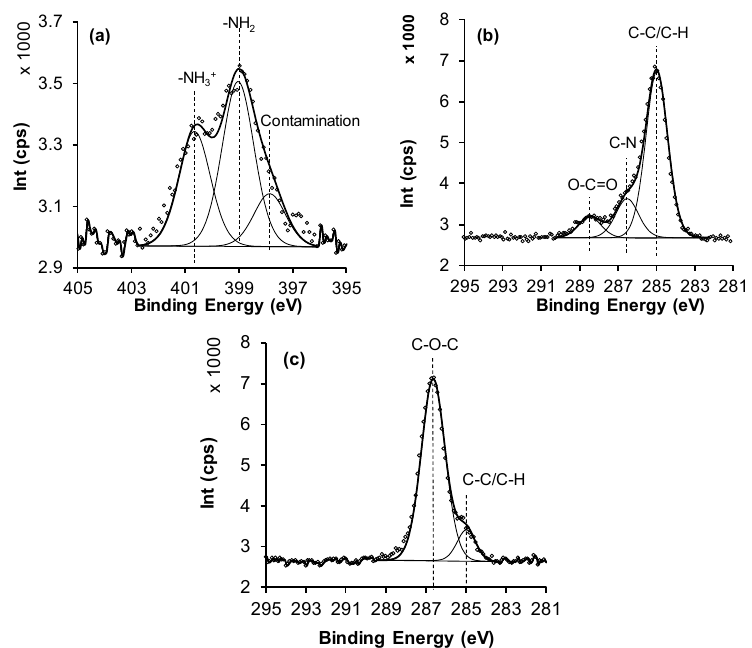
Figure 2. Selected XPS spectra for modified surfaces: ( a ) N 1s spectrum of 4% APTES, ( b ) C 1s spectrum of 4% APTES, and ( c ) C 1s spectrum of PEG grafted under ”cloud point” conditions.